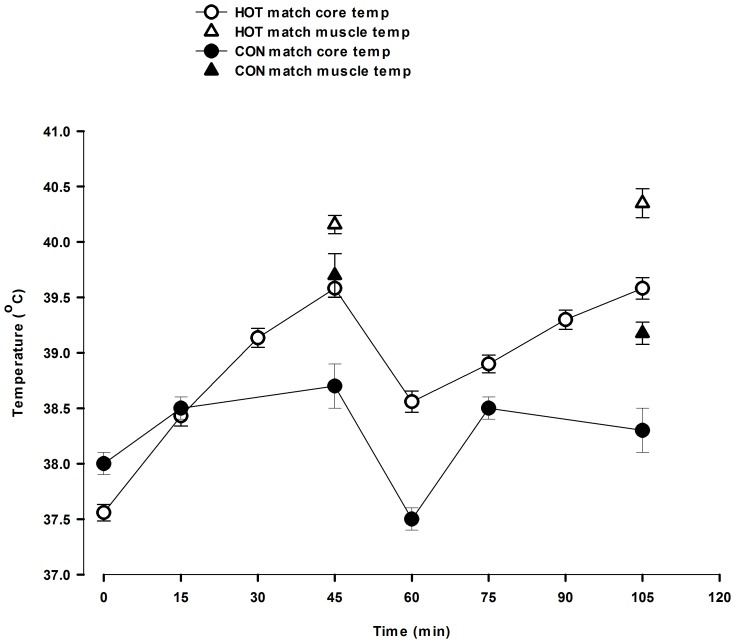
Muscle temperature (Tm; triangles; N = 12) and core temperature (Tc; circles; N = 17) after the first and second half in HOT (open symbols) and CON (closed symbols).